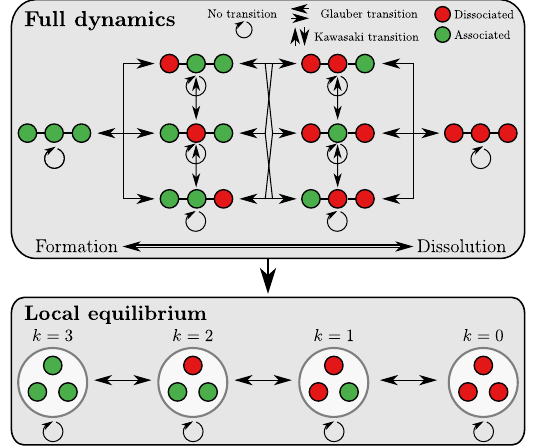
FIG. 6. Mapping the full dynamics onto a birth-death process. For convenience, and without any loss of generality, we show here an example of a system composed of three adhesion bonds on a one-dimensional lattice. The mapping holds for any lattice geometry. In the full dynamics, each lattice configu- ration represents a different node, comprising a 2 N × 2 N tran- sition matrix, whereas in the local equilibrium approximation, we only need to distinguish between states with a different number of closed or open bonds, comprising a ð N þ 1 Þ × ð N þ 1 Þ transition matrix.